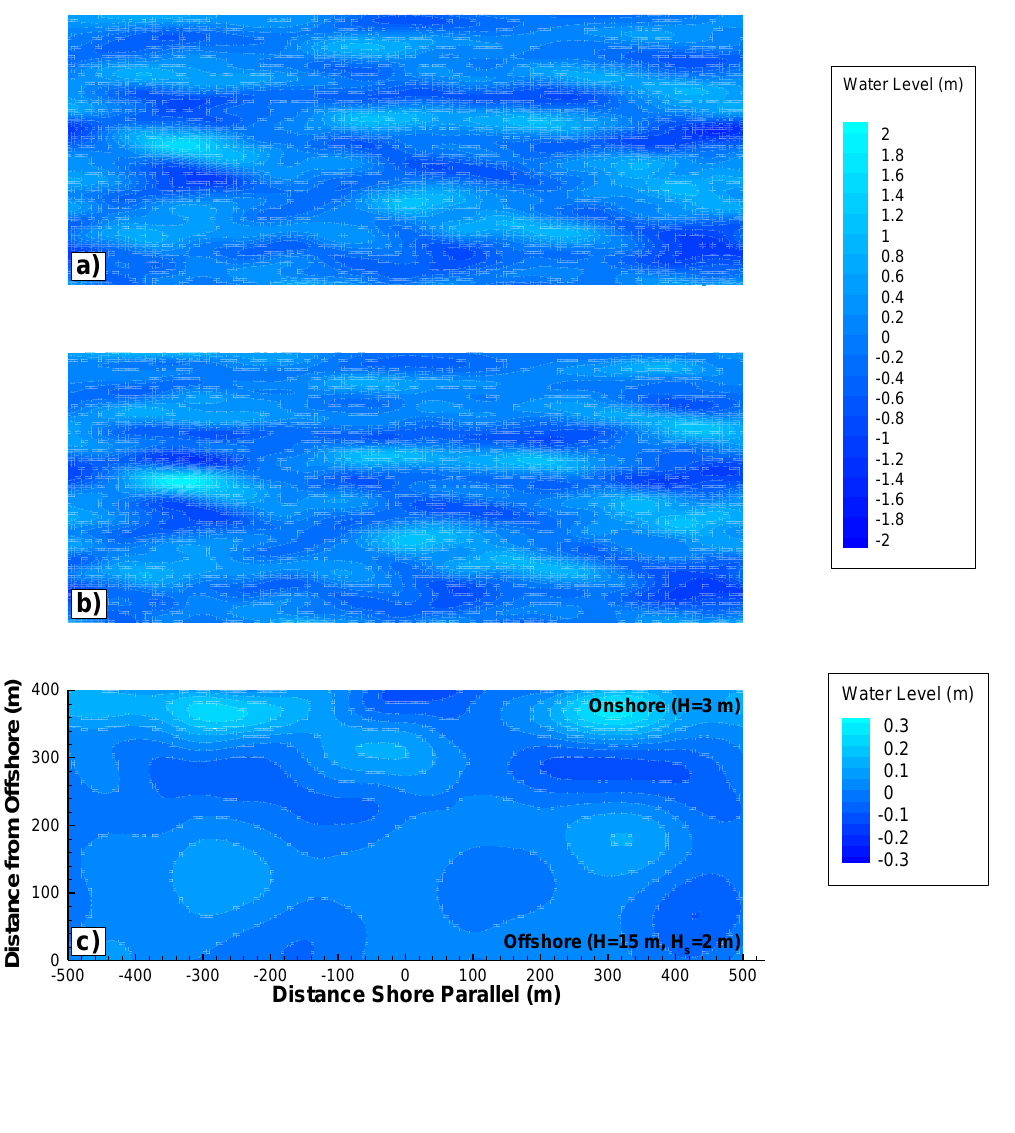
Figure 8. Contours of the simulated free surface elevation field for shore-perpendicular propagation, corresponding to the spectrum shown in Figure 6 at a fixed (arbitrary)